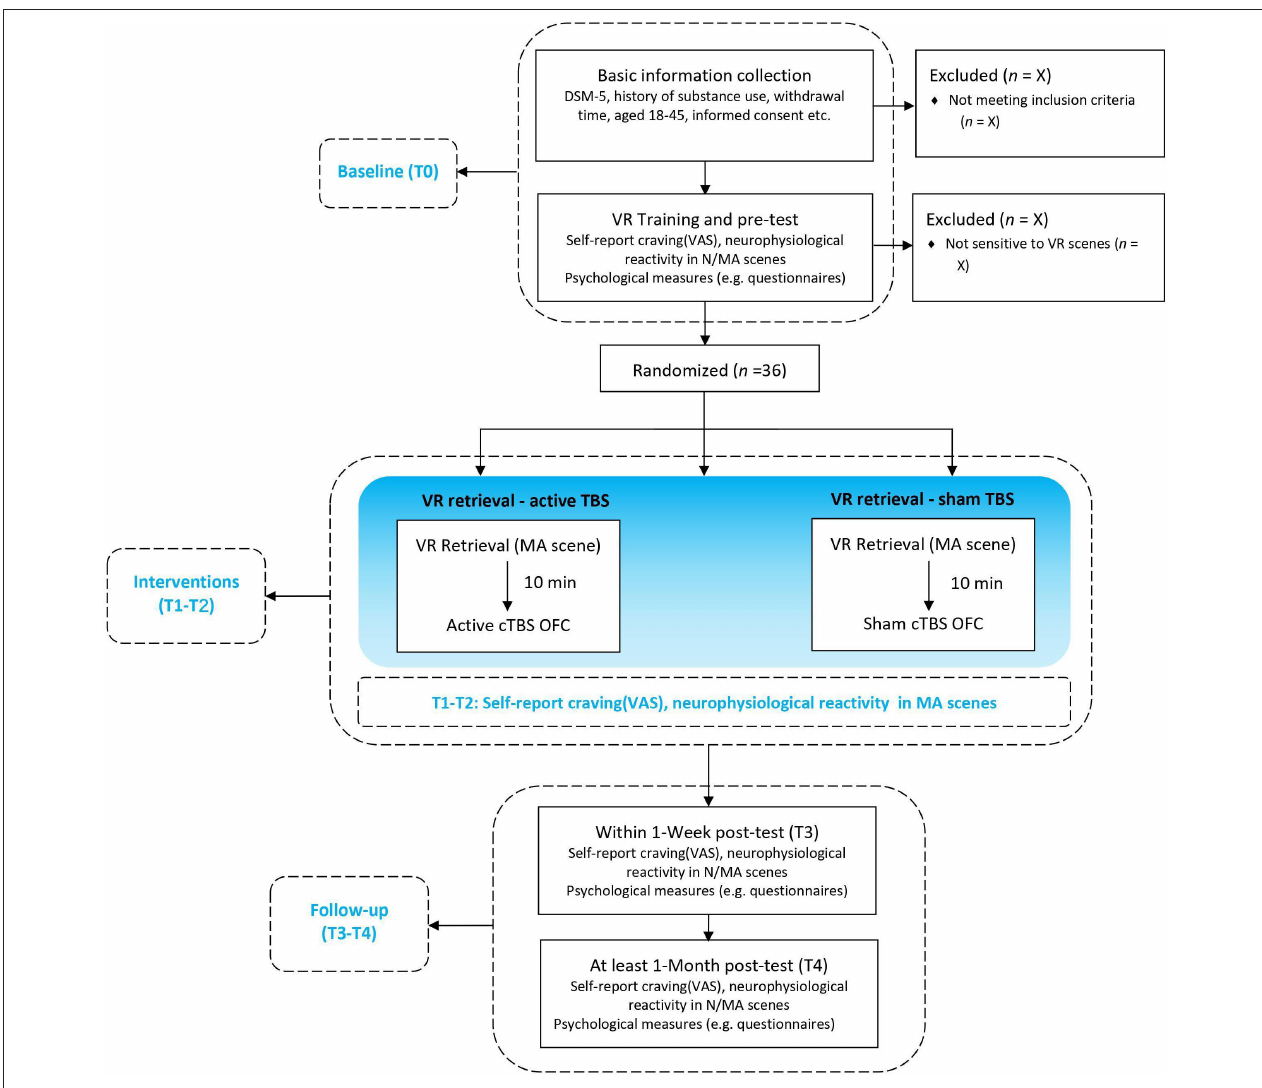
FIGURE 1 | Flow chart of the study design. VR, Virtual Reality; N/MA scenes, neutral/methamphetamine scenes (displayed by VR); cTBS, continuous theta-burst stimulation; OFC, orbitofrontal cortex; neurophysiological reactivity including electroencephalogram (EEG) activities and electrocardiography (ECG) activities in outcome